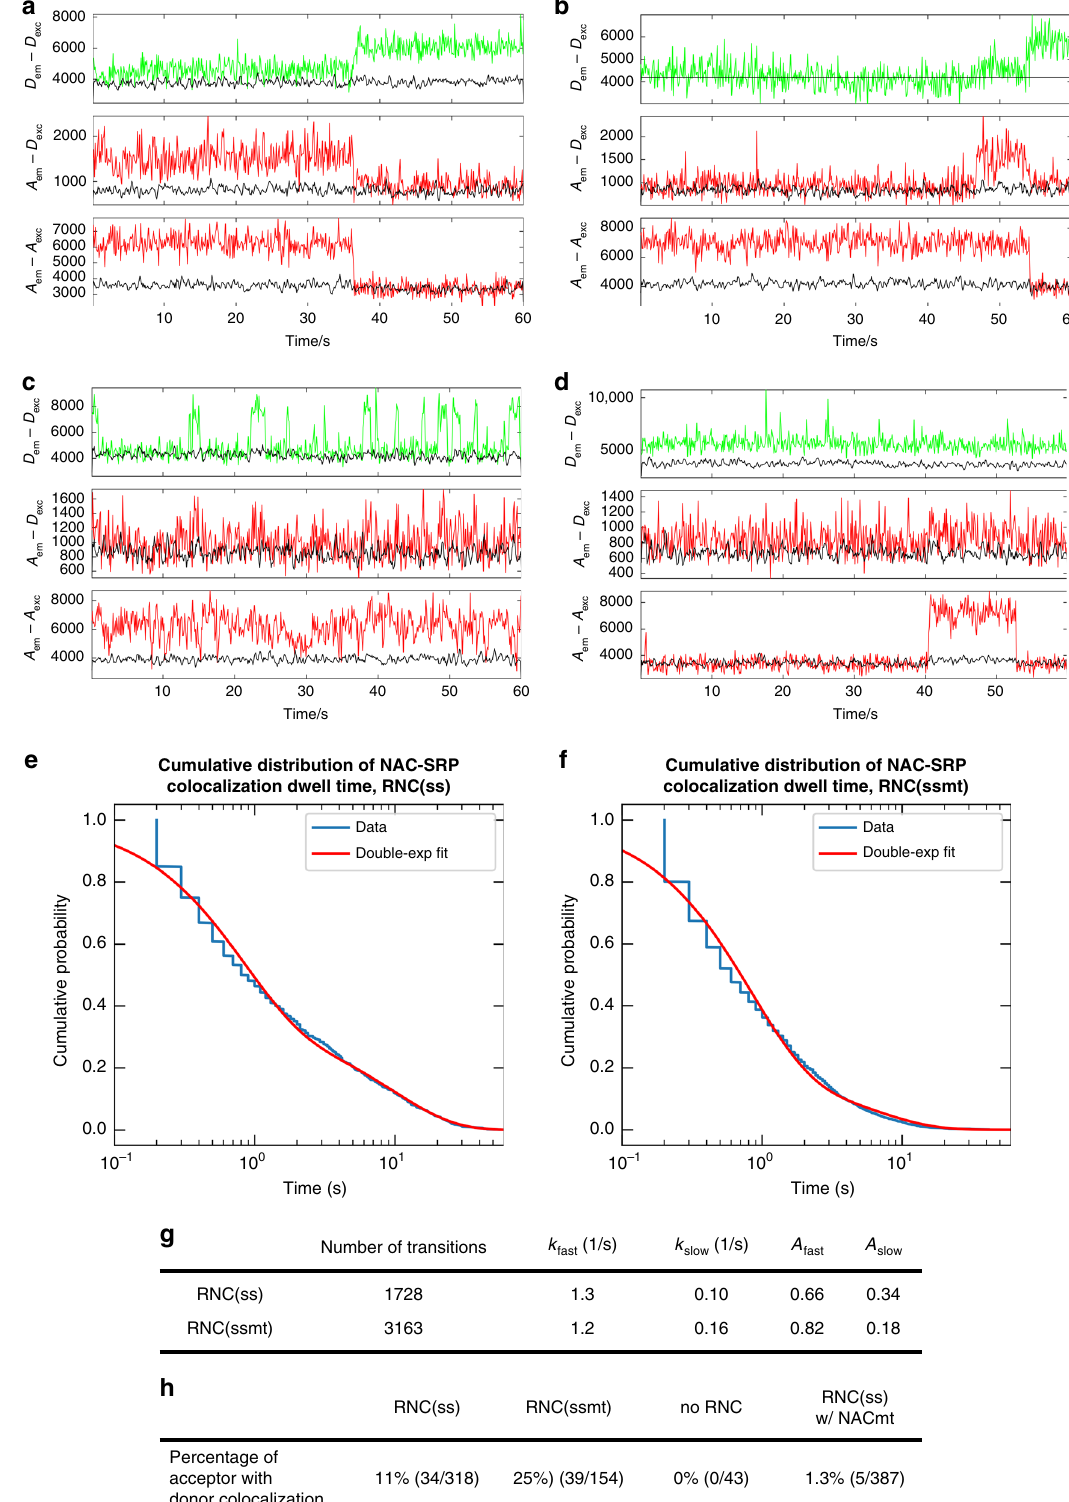
Signal sequence-dependent regulation of SRP conformation by NAC . To directly observe NAC-induced conformational changes of SRP on the RNC, we used a FRET pair in SRP that reports on the proximity between the SRP54 NG-domain (labeled with Atto647n as the acceptor dye) and SRP19 (labeled with Atto550 as the donor dye) adjacent to the ribosome exit site 10 (Fig. 6a). Previous solution-